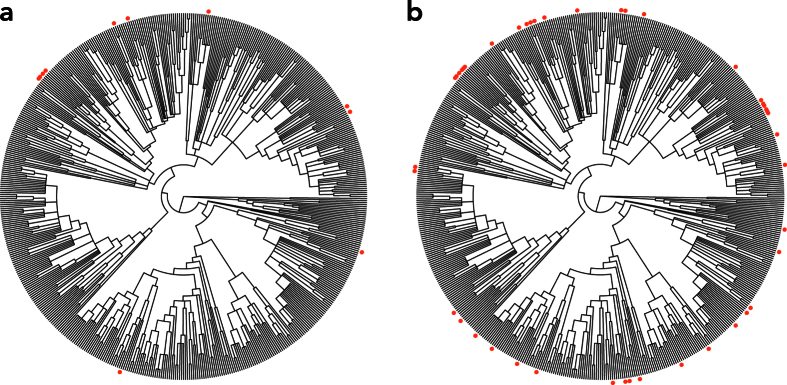
Phylogenetic distribution of species for (a) the Economic Botany Data Collection Standard (EBDCS) category inflammation and (b) the category inflammatory response. Red dots indicate species with documented use described in the category.